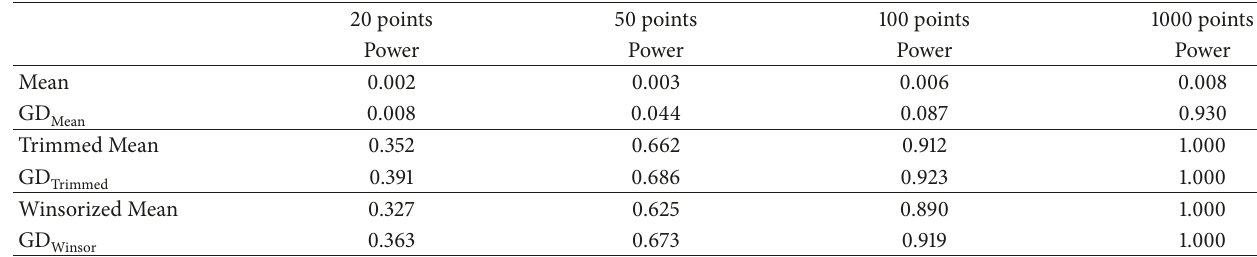
Table 45: Contaminated 𝜒 2 distributions with 30% noise